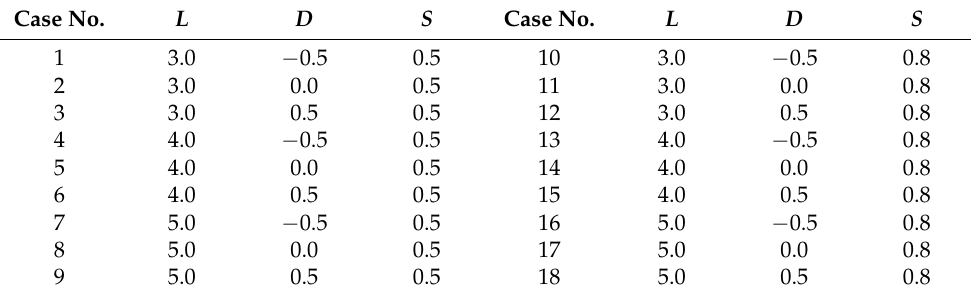
Table 4. Experimental conditions.